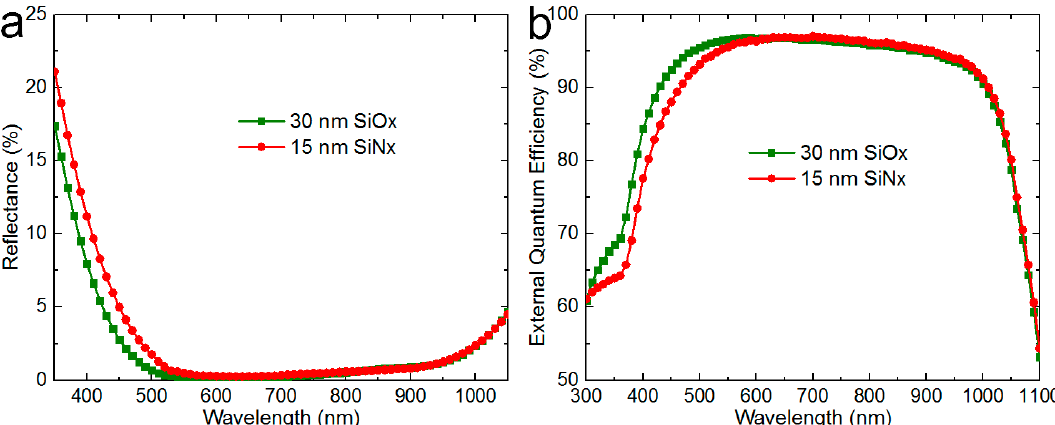
Figure 5. ( a ) Reflectance curves of the 30 nm SiO x third layer sample and the 15 nm SiN x third layer sample before metallization. ( b ) External quantum efficiency curves of the 30 nm SiO x third layer sample and the 15 nm SiN x third layer sample after